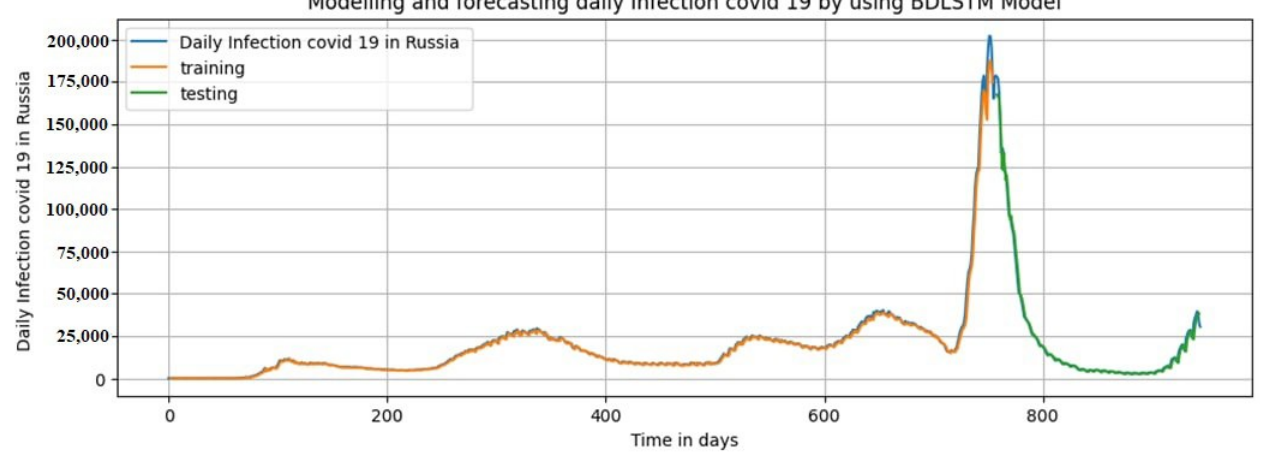
Figure 10. Comparison of the forecasting SARS-CoV2 infection cases and the real infection cases for BDLSTM.